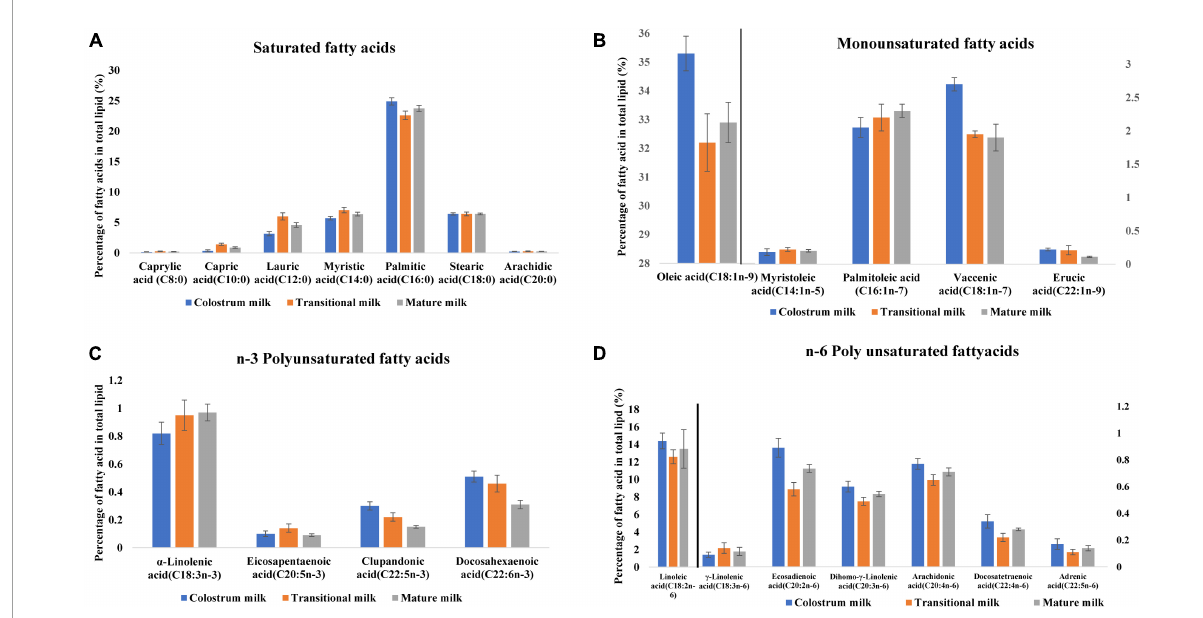
FIGURE4 Fatty acid profile of breast milk across lactation stage (21). (A) Saturated fatty acids profile of breast milk across lactation stage. (B) Monounsaturated fatty acids profile of breast milk across lactation stage. (C) n -3 Polyunsaturated fatty acids profile of breast milk across lactation stage. (D) n -6 Polyunsaturated fatty acids profile of breast milk across lactation stage. Lactation stage—colostrum milk 0–5 days of postnatal life, transitional milk—6–15 days of postnatal life, and mature milk—16–60 days of postnatal